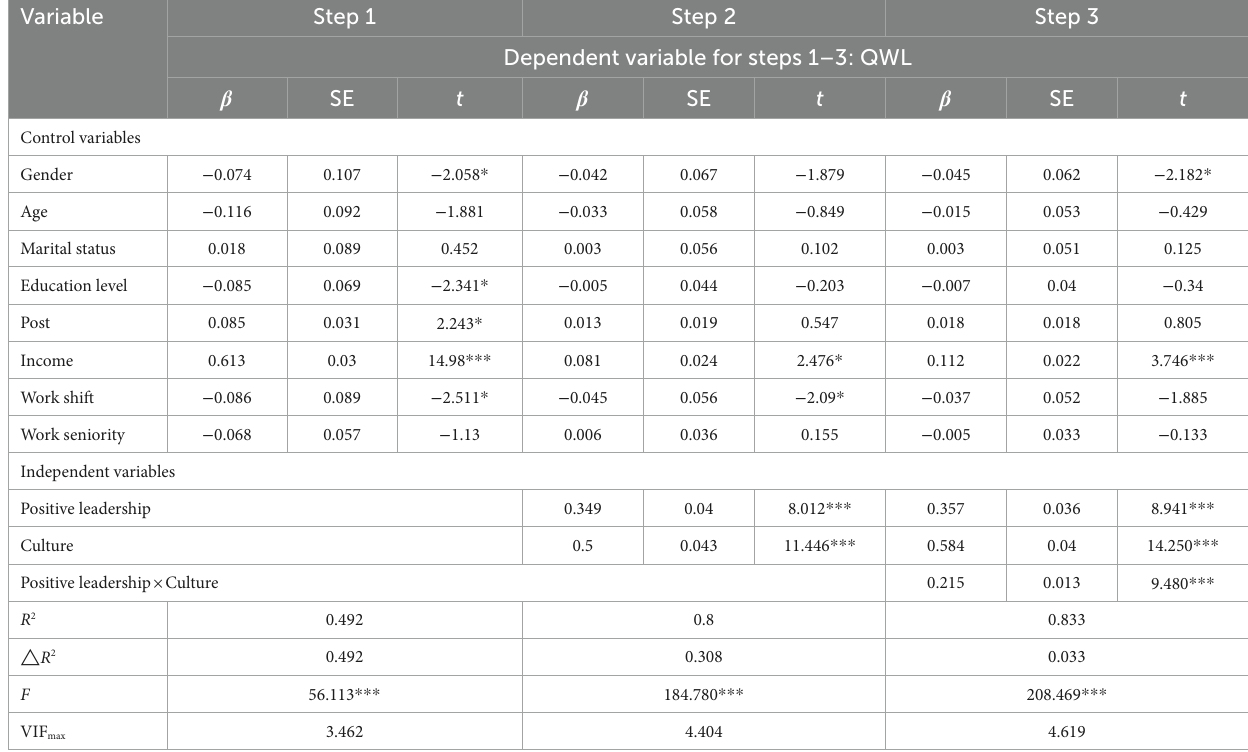
TABLE 8 Moderating effect of culture on the relationship between positive leadership and